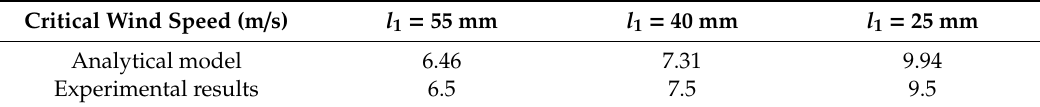
Figure 4. The RMS open-circuit voltage of energy harvester with different magnets positions. Table 5. Comparison of critical wind speed between the analytical predictions and the experimental results.